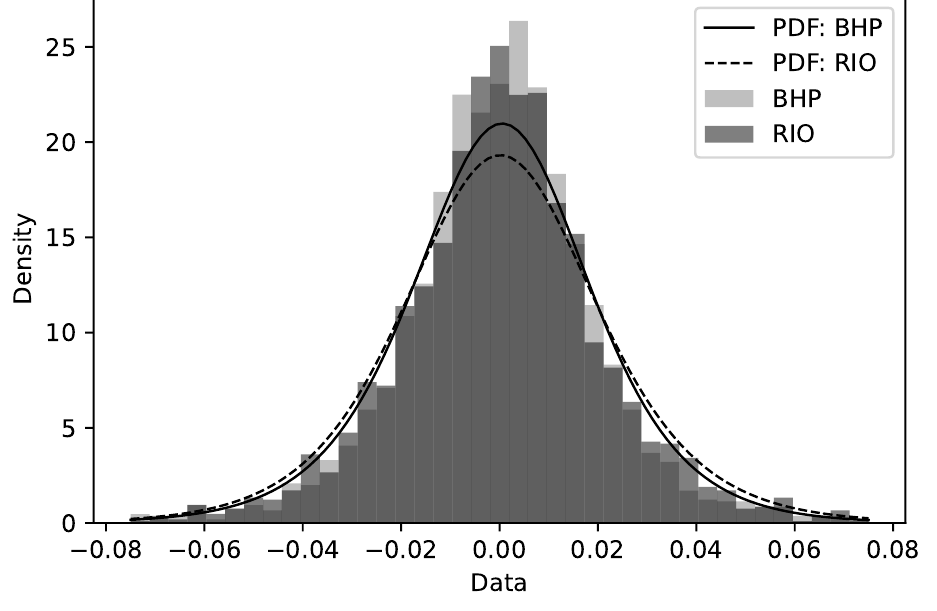
Figure 3. Stocks BHP and